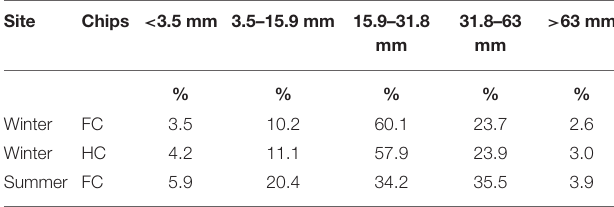
TABLE 2 | Particle size distribution of fresh (FC) and hot water extracted (HC) willow chips that were placed in bags and inserted into storage